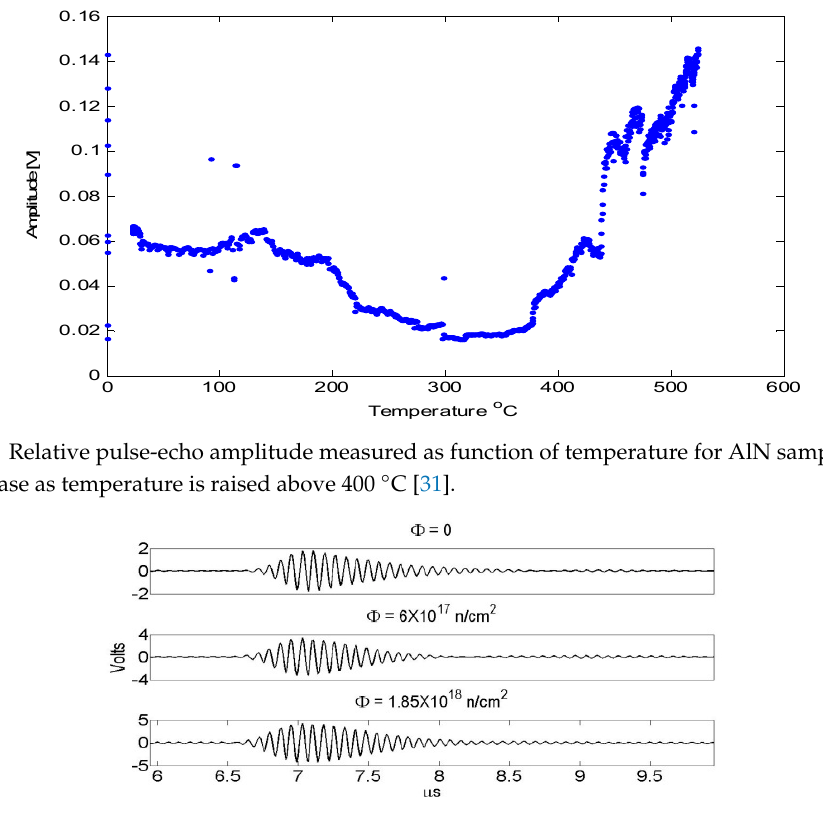
Figure 10. A-Scans obtained from AlN TRIGA reactor core, Φ is the fast neutron fluence [31].